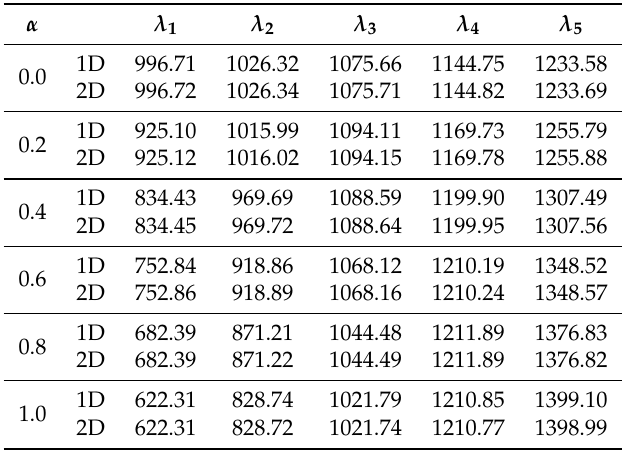
Table A1. The first five eigenvalues for the case h = α e α u 2D